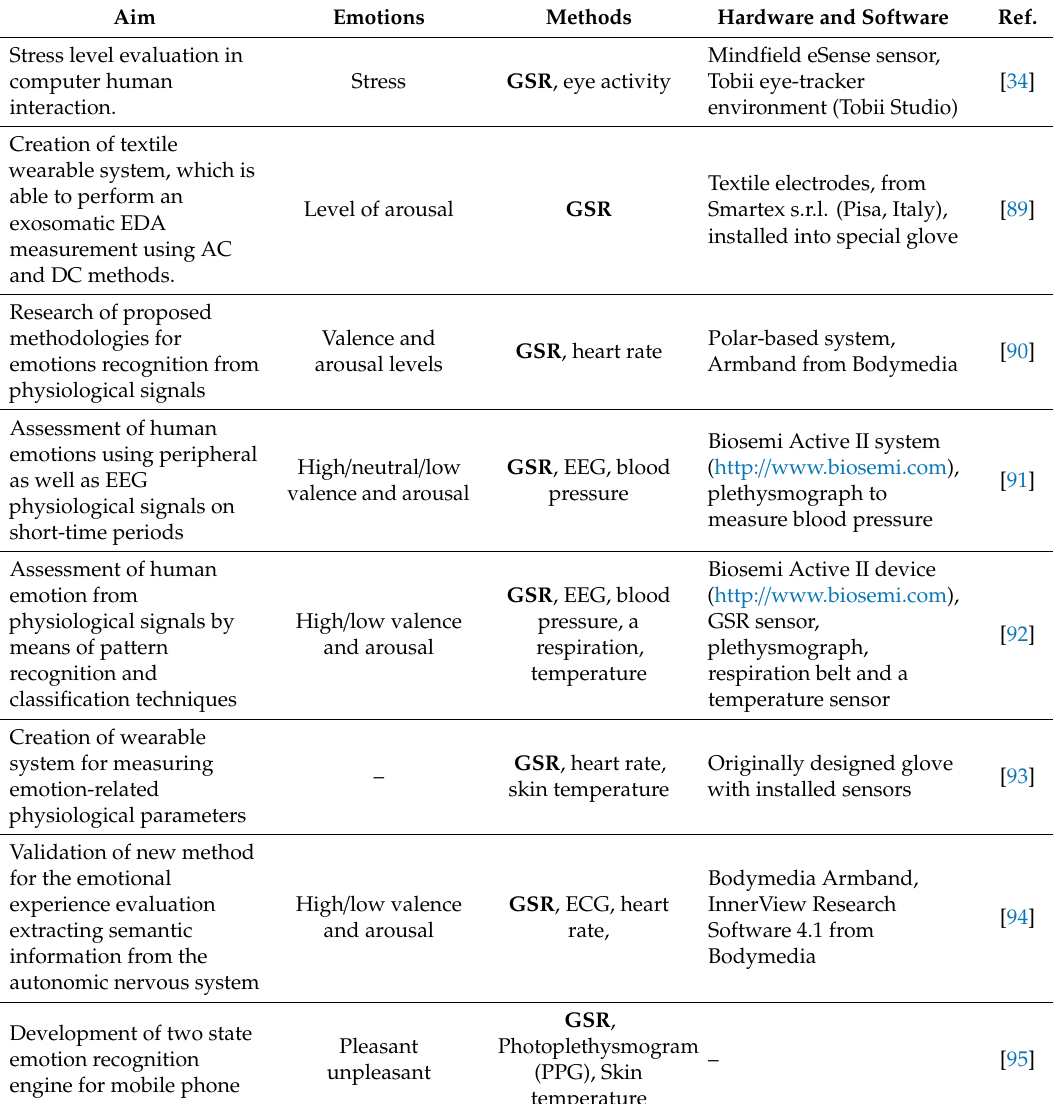
Table 5. Review of scientific researches focused on emotions recognition and evaluation using